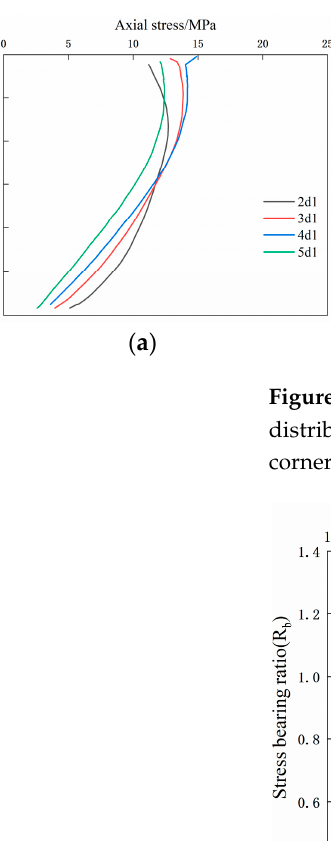
14 of 18 Figure 16. The ratio curve of end resistance to average friction resistance.